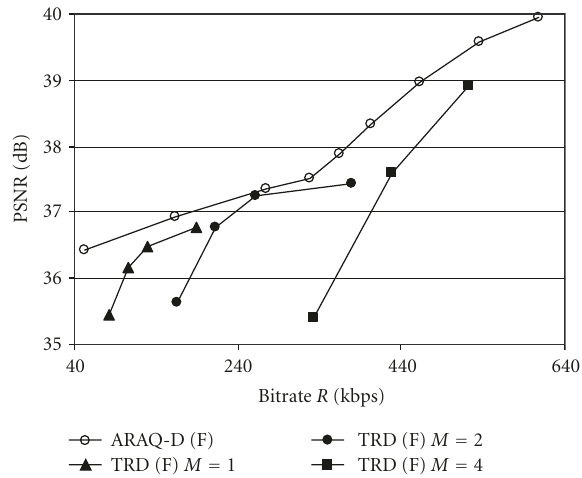
Figure 11: R-D curves for the Foreman (F) sequence obtained with the ARAQ-D technique, compared to the performance of a TRD system.